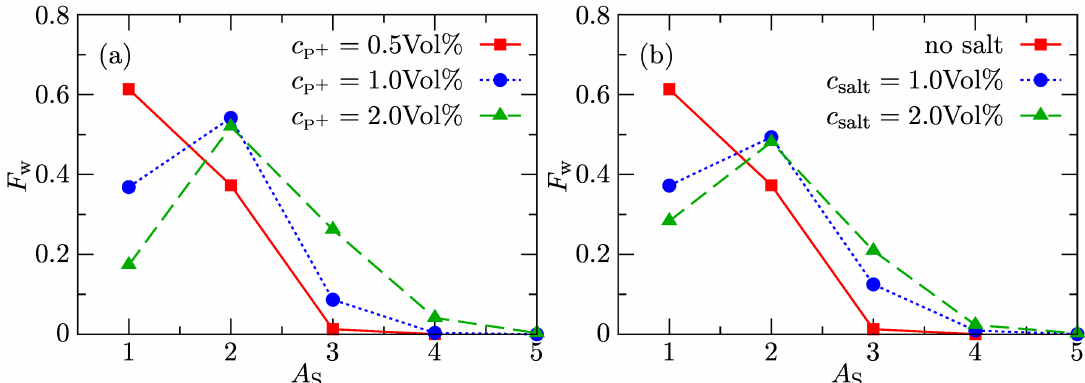
Figure 2. Weight distribution function of aggregation numbers F w ( A S ) for ( a ) different amounts of porphyrins without added salt and ( b ) different amounts of added salt at porphyrin concentration c